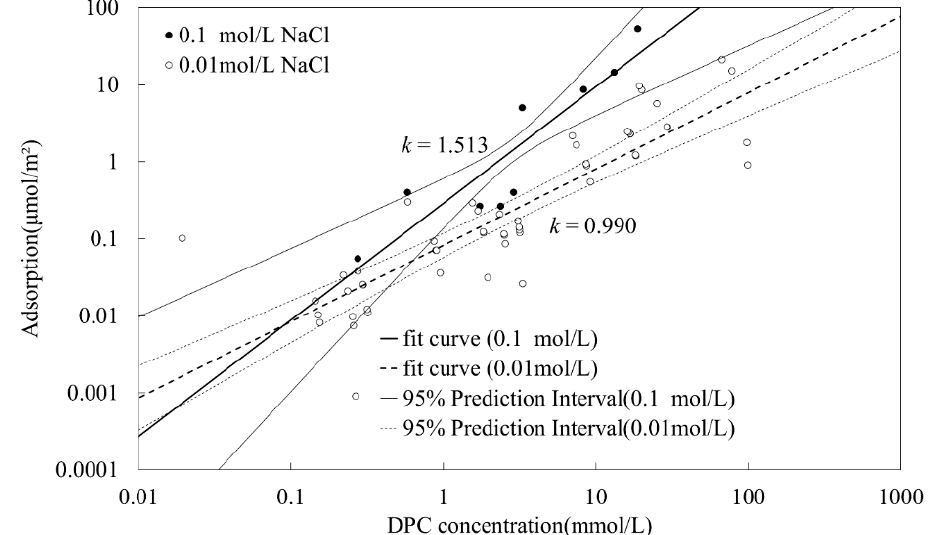
Figure 5. Dodecyl pyridinium chloride (DPC) adsorption amounts on silica under different DPC and electrolyte concentrations at pH 5, with linear regression line and confidence interval for each electrolyte concentration.